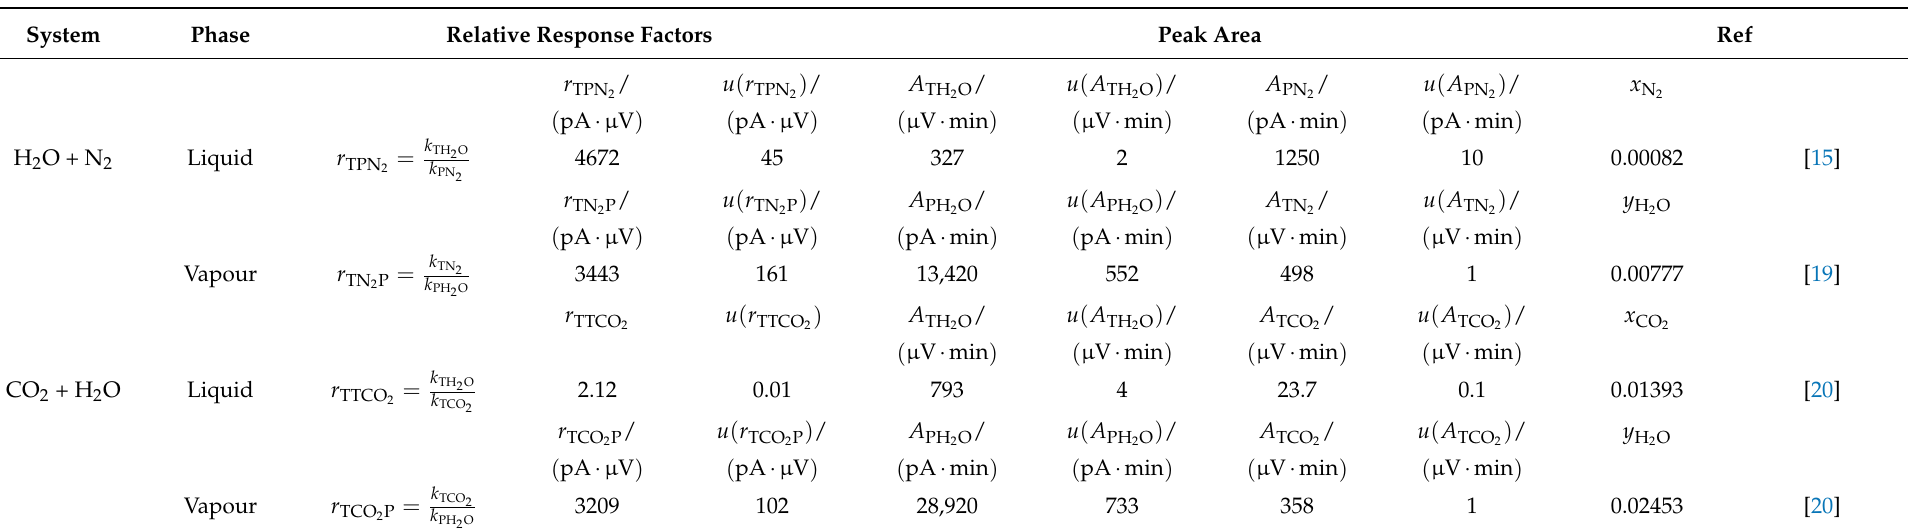
Table 5. Relative response factor, r ; response factor, k ; and chromatographic peak areas, A . The subscripts T and P indicate TCD and PDHID detectors, respectively. Literature data of the binary